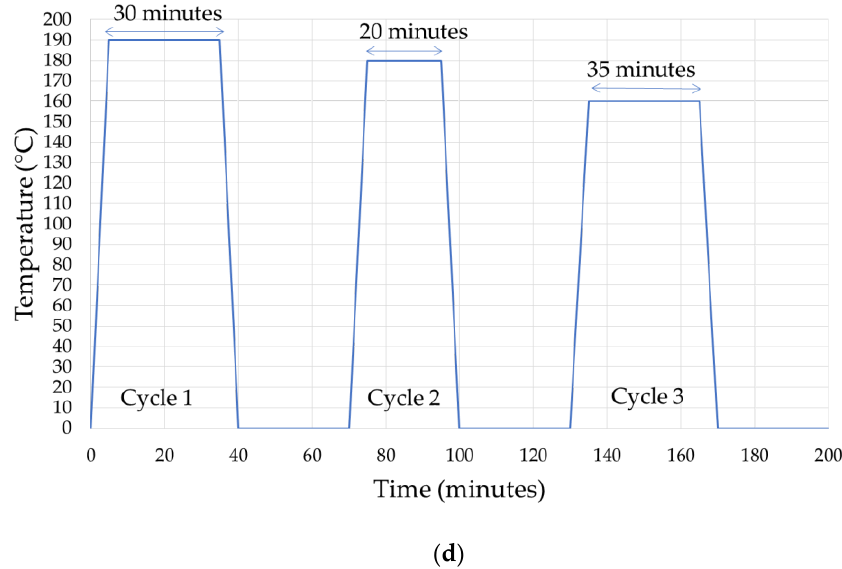
Figure 5. ( a ) Schematic and ( b , c ) photographs of the experimental setup for strain measurement during the thermal cycle. ( d ) Graphical representation of the thermal cycle after post curing of the carbon fiber SMC (CFSMC) and aluminum (Al) adherends to simulate electrodeposition paint (E-coat) process.